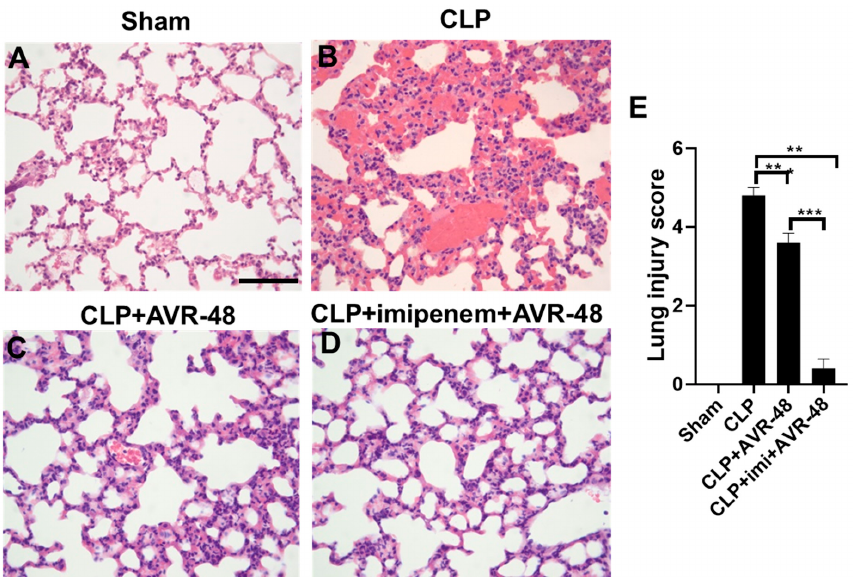
Figure 7. Treatment with AVR-48 showed decreased lung injury in CLP-induced ALI in mice. Representative image of H/E-stained lungs of CLP-induced lung injury in mice receiving AVR-48 treatment. ( A ) Normal lungs in the sham group. ( B ) In the CLP group, the alveolar membranes show fragmentation leading to expansion of alveolar sacs associated with severe vascular congestion, thrombosis, and hemorrhage. ( C ) Signs of lung injury are diminished after treatment with AVR-48 alone or ( D ) with a combination of imipenem + AVR-48. A CLP + imipenem group was not done here, as we published that finding earlier and observed that AVR-25 demonstrated better efficacy when given in combination with imipenem, than with imipenem alone. Scale bar = 100 µm representative of ( A – D ). ( E ) Right panel shows lung injury scores with severe injury in the CLP group followed by significant recovery after treatment with AVR-48 alone or with imipenem+AVR-48. ** p < 0.01; *** p < 0.001. Data are expressed as mean ± SEM. For statistical analysis, student’s unpaired t -test and one-way analysis of variance (ANOVA) followed by Tukey post hoc analysis were used. CLP: cecal ligation and